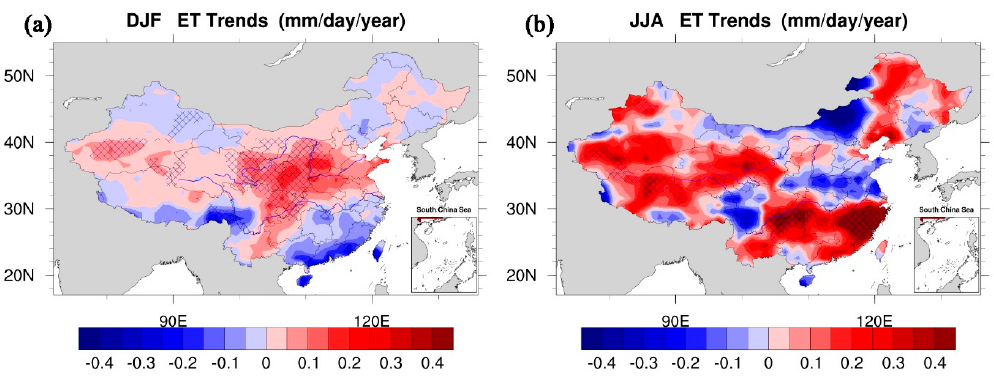
Figure 3. ET MK trend distributions of multiyear averages in winter ( a ) and summer ( b ) after 1998. Blue is negative, and red is positive. The grid lines indicate that the 95% significance test is passed.